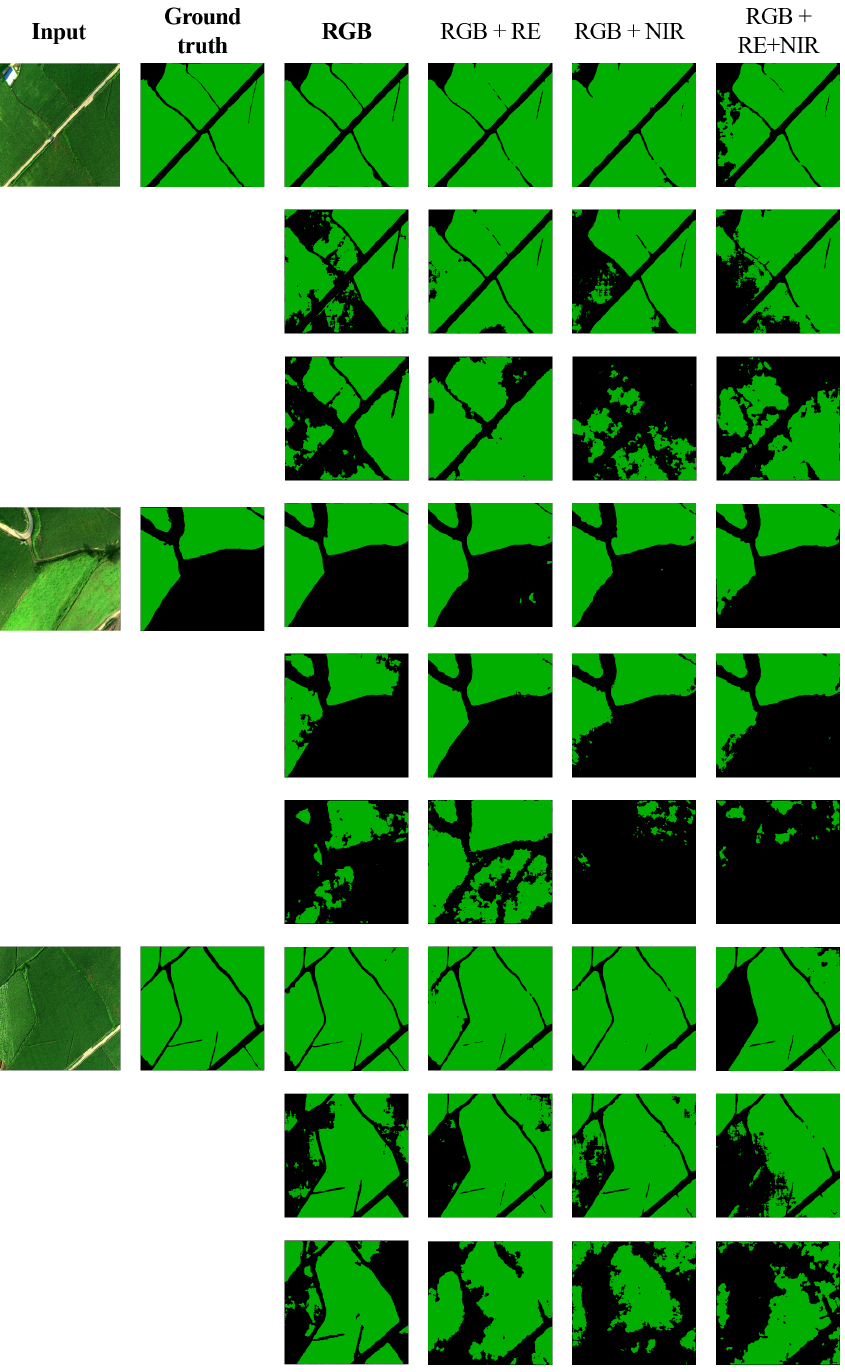
Figure 7. Visualization of model predictions for three representative examples from the MBS dataset. There were input images and ground truth in the first and second columns. Prediction results are represented from the third column to the sixth column. Results of DeepLab V3+, U-Net, and SegNet are repeatably visualized from the first row to the final row. The area occupied by each input in Maebongsan is about 1.77 ha. Each input image width and height of DeepLab V3+, U-Net, and SegNet is 513, 572, and 224,